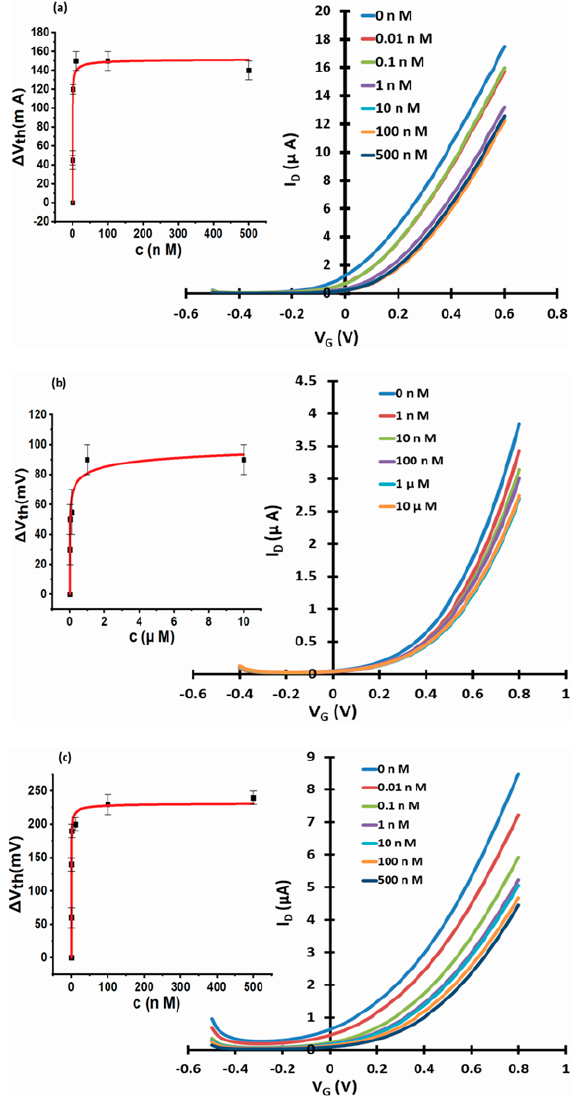
Figure 8. WGTFT fluoride sensors under chloride and carbonate as interferants. ( a ) Response of La-loaded resin to chloride from NaCl. ( b ) Response of Al resin to chloride from NaCl. ( c ) Response of La resin to carbonate. Insets: Response characteristics with fits to Equation (3).